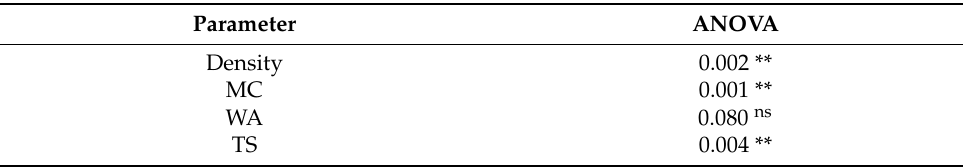
Figure 3. Effect of wood shaving on density and MC of elephant dung particleboard. Table 3. Variance analysis summary of physical properties.